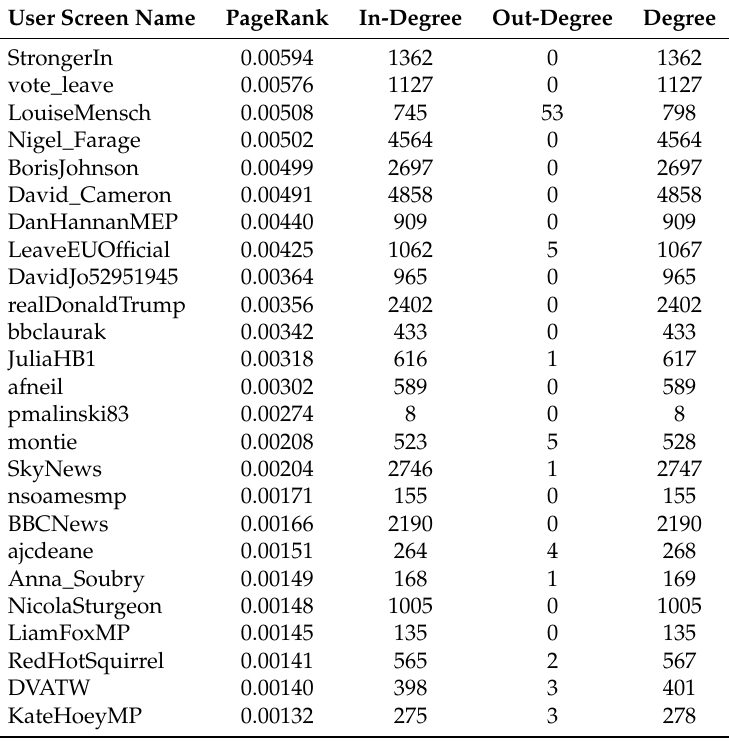
Table 4. Most Influential Users.